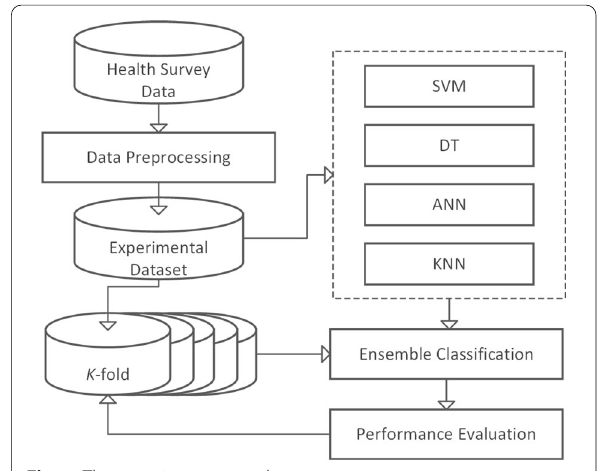
Fig. 4 The experiment procedure